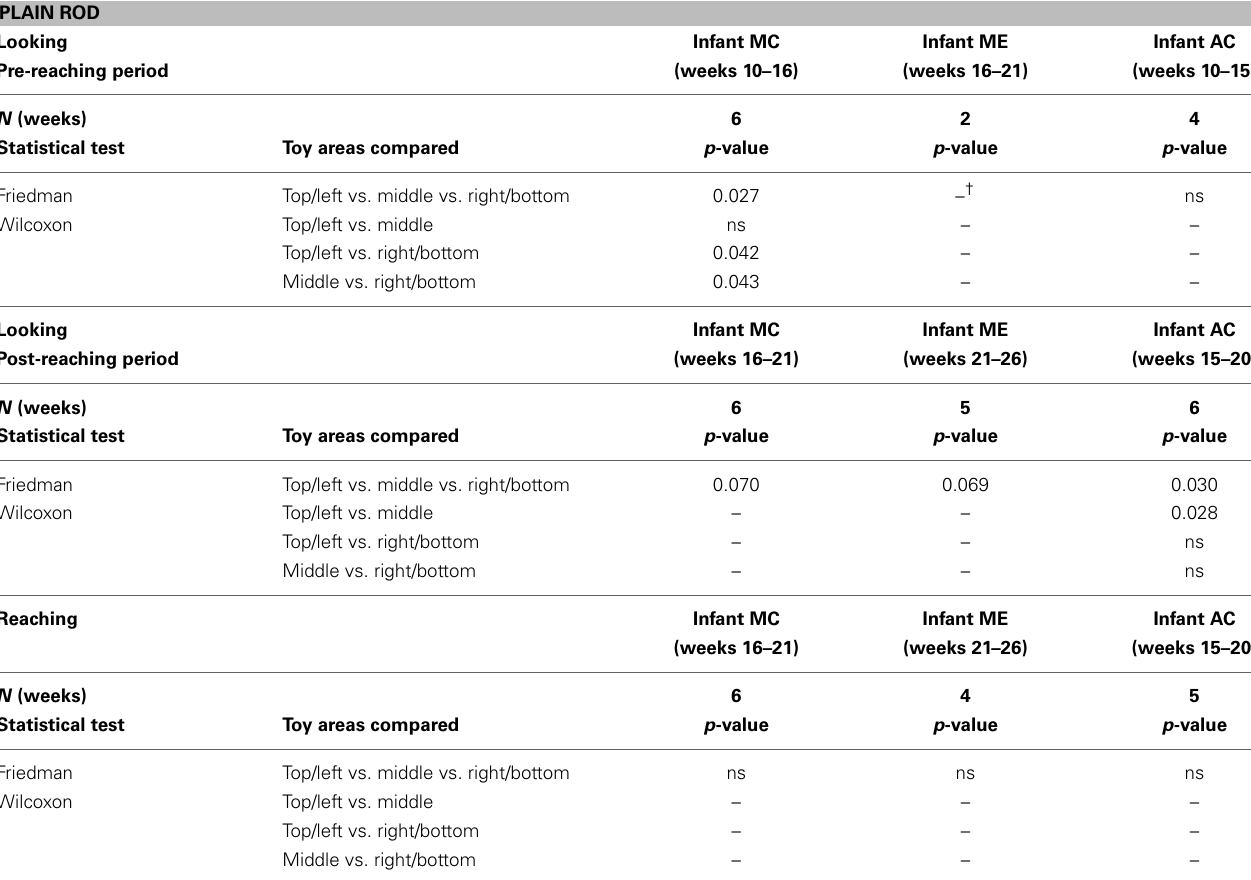
Table 3 | P -values obtained from the statistical tests applied to (1) the individual distributions of accumulated looking directed to each of the three areas of the plain rod (top/left, middle rod, right/bottom rod) for the pre- and post-reaching periods, and, (2) P -value of the statistics applied to the individual distributions of the first hand/object